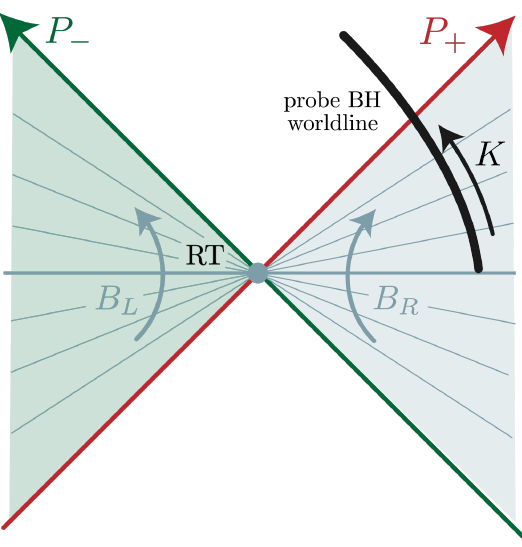
Figure 7. The modular Hamiltonian K of the probe black hole propagates the local atmosphere operators in proper time along its worldline, even past the Rindler horizon. K can be expressed as a linear combination (5.1) of the two (decoupled) Rindler Hamiltonians B the left and right wedge, respectively, and the ANEC operators P null directions and, therefore, mix the two operator algebras, resolving the Marolf-Wall